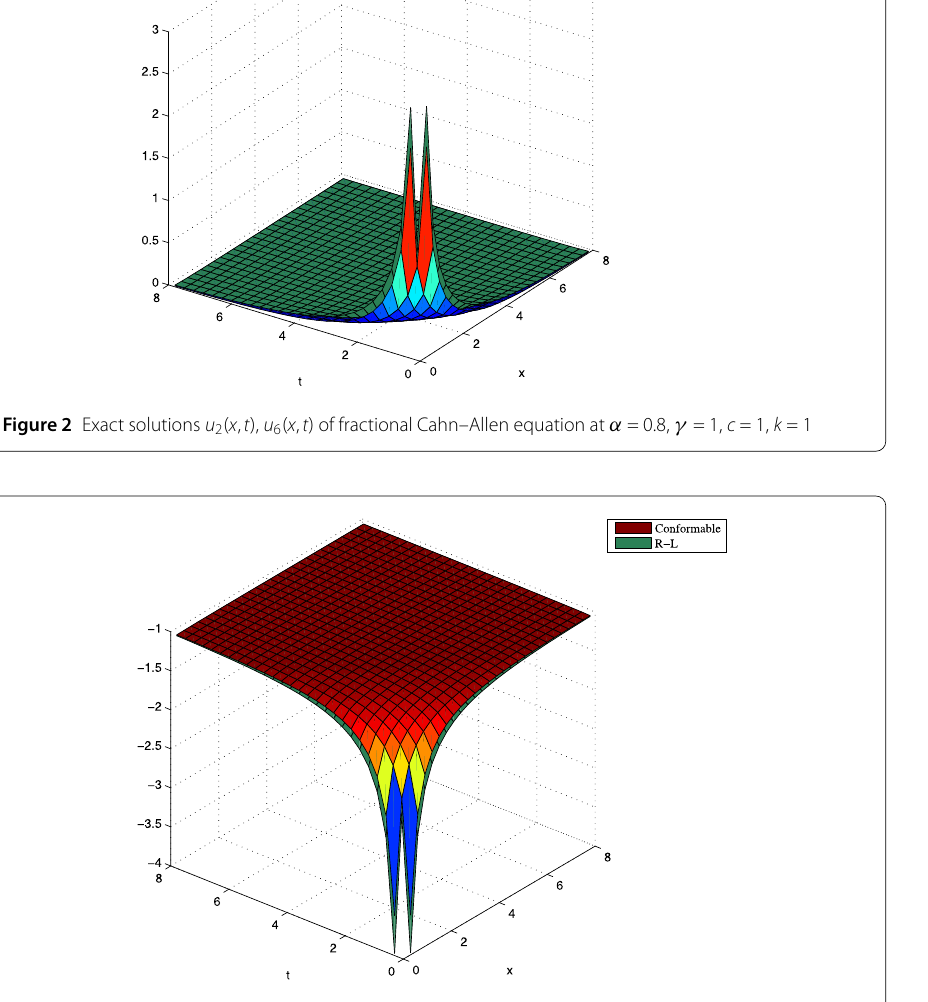
Figure 3 Exact solutions u 3 ( x , t ), u 7 ( x , t ) of fractional Cahn–Allen equation at α = 0.8, γ = 1, c = 1, k = 1